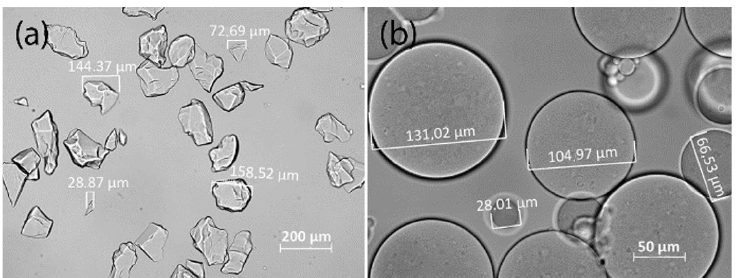
Figure 3. Particles used for the chip application. ( a ) Non-spherical particles. ( b ) Spherical particles. Pictures are 40× magnified.